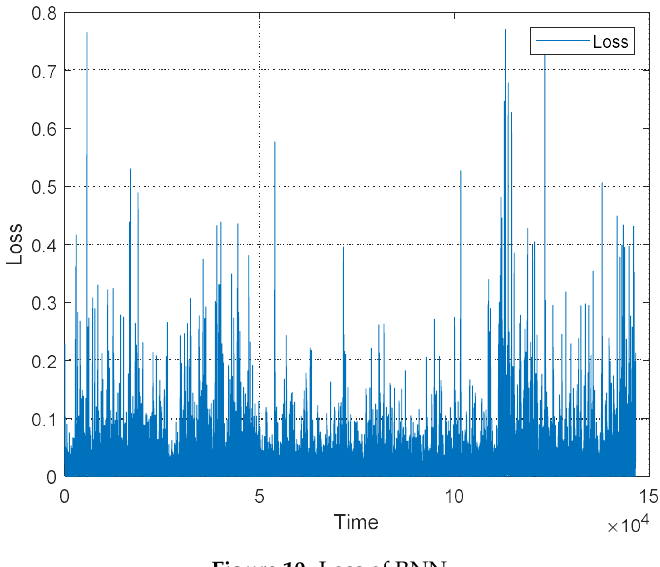
Figure 10. Loss of RNN. Table 2. Average loss rate of each of the architectures.